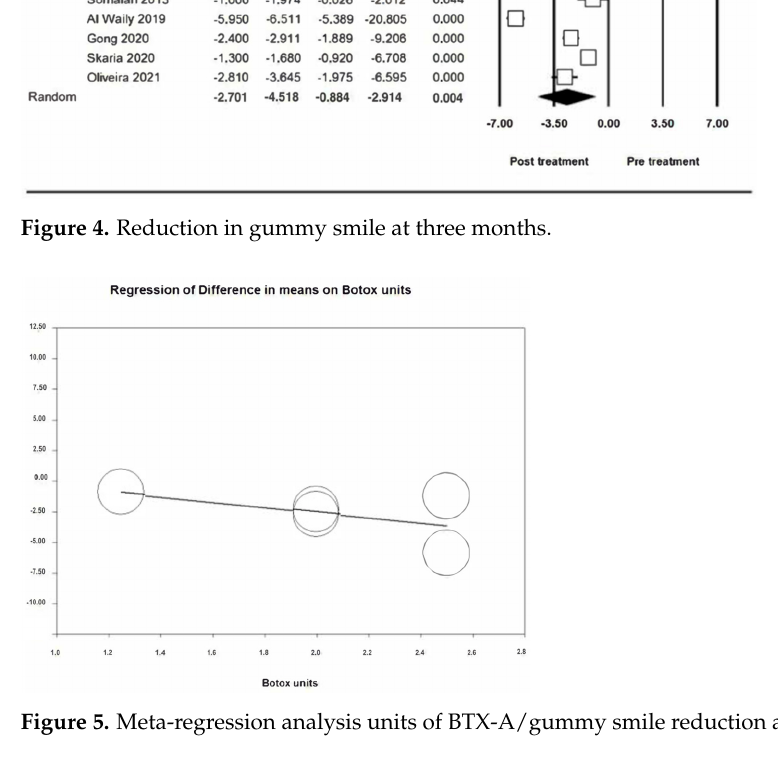
Figure 5. Meta-regression analysis units of BTX-A/gummy smile reduction at 3 months. Through a subgroup analysis, no significant differences are found between the esti- mates of gummy smile reduction at two weeks and three months (Q test for intergroup heterogeneity = 0.221; p value = 0.638). Similarly, through a meta-regression in which the 11 studies are included, no significant effect of the follow-up time on the reduction in the gummy smile is found ( p value = 0.630) (Figure